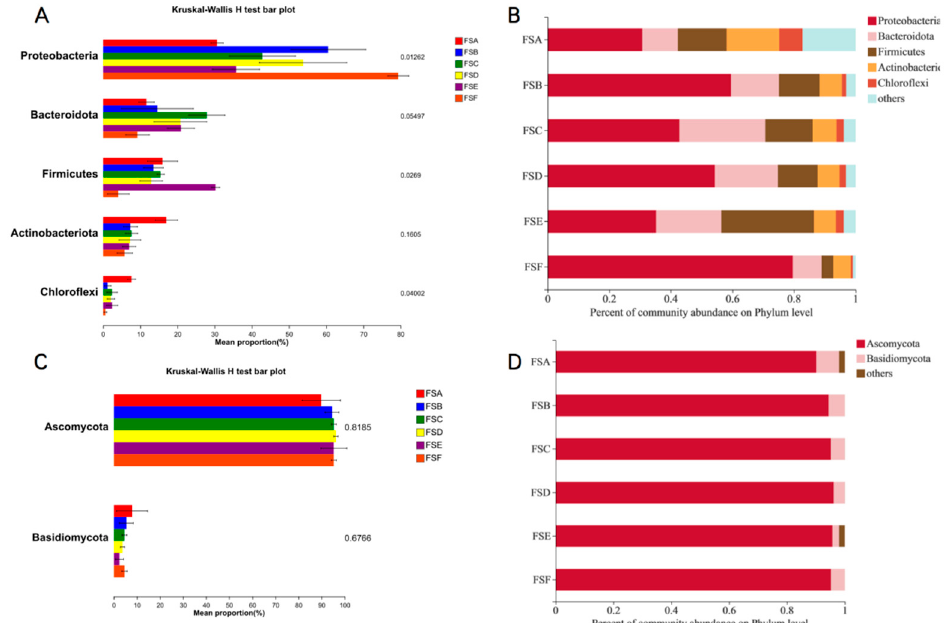
Figure 3. Relative abundance at the phylum level of microbial communities in soils with different treatments. Note: ( A ) differences in relative abundance of bacterial communities; ( B ) relative abundance of bacterial communities; ( C ) differences in relative abundance of fungal communities; ( D ) relative abundance of fungal communities.